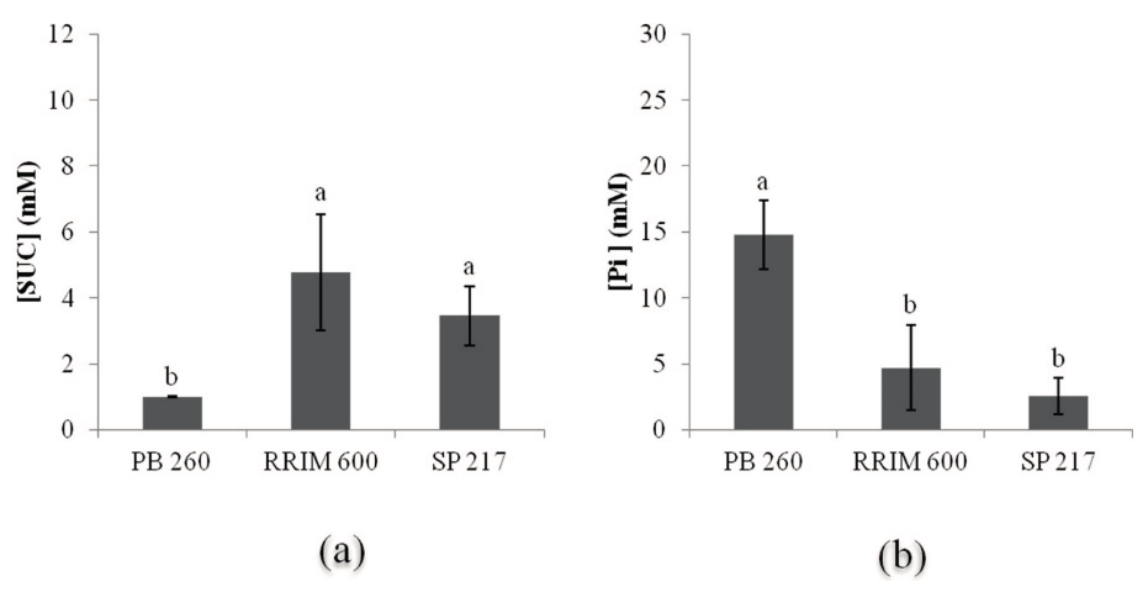
Figure 2. Metabolic typology for three rubber clones (PB 260, RRIM 600, and SP 217) with contrasted latex metabolism based on sucrose (SUC) and inorganic phosphorus (Pi) content in latex. The ANOVA test and the Newman–Keuls test were used in the statistical analyses ( p < 0.05). ( a ) Sucrose content; ( b ) Inorganic